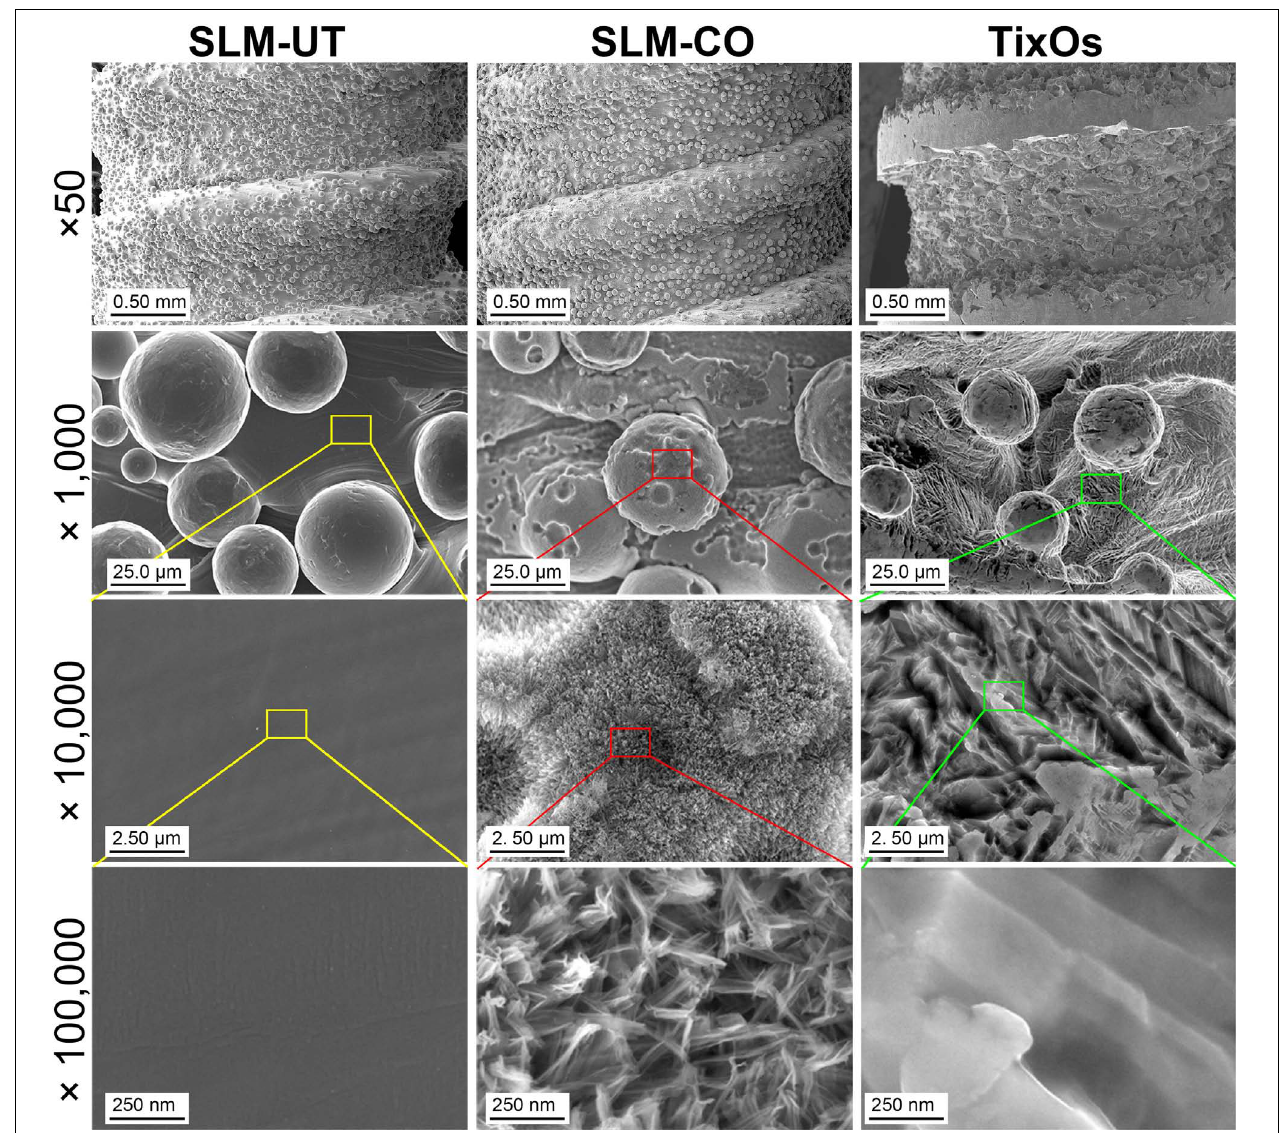
FIGURE 1 | Surface topography of three implants by the field emission scanning electron